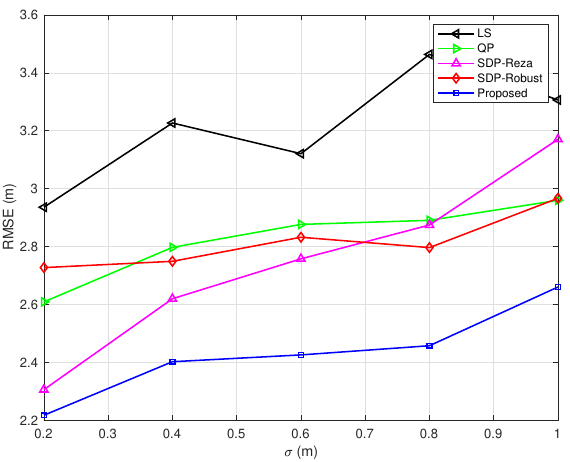
Figure 6. RMSEs vs. σ ( B max = 10 m and the number of NLOS links equals 6 )